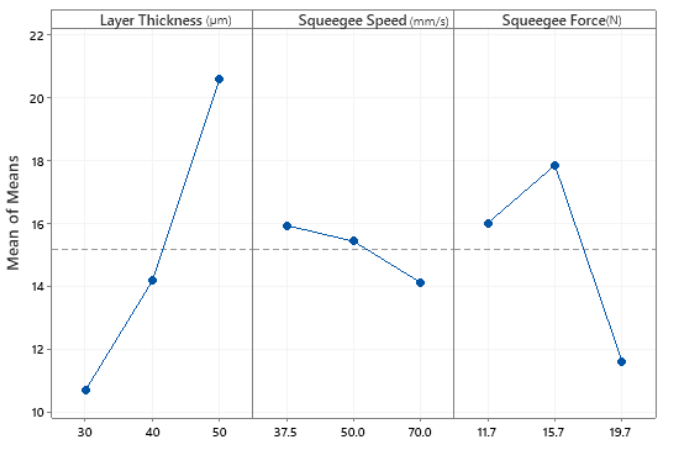
Figure 5. Main effect of the plot for mean values.